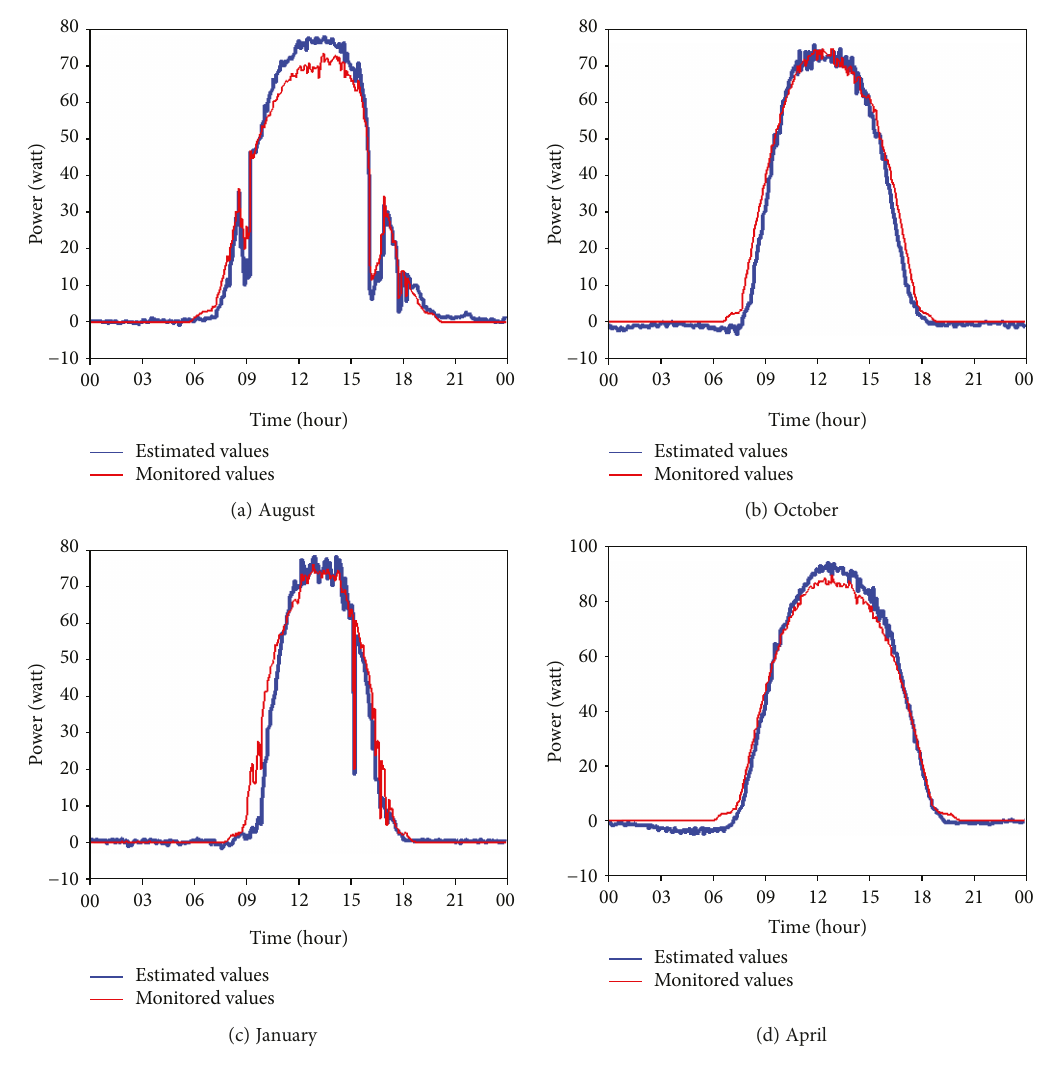
Figure 9: Sample estimation graphs for Sanliurfa. Table 7: Performance comparison of technique